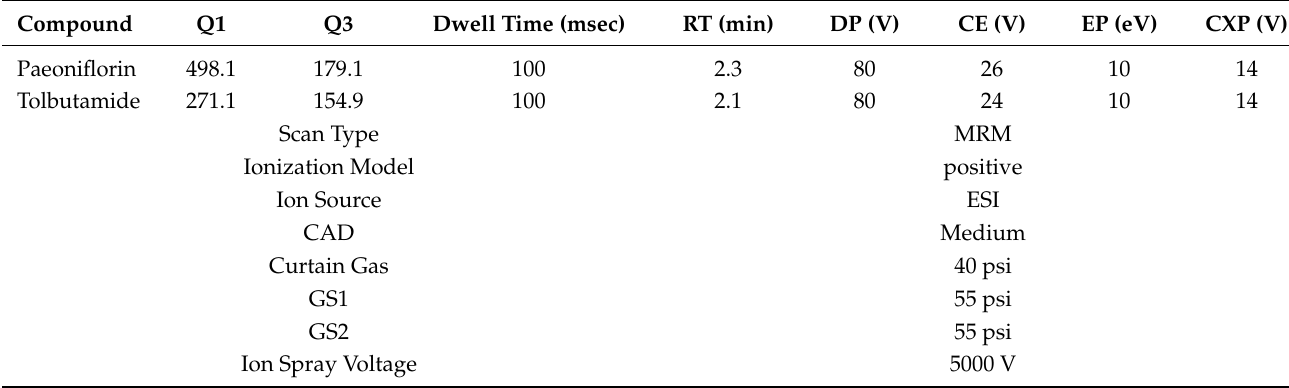
Table 1. Mass spectrometric parameters for paeoniflorin and tolbutamide (IS). Compound